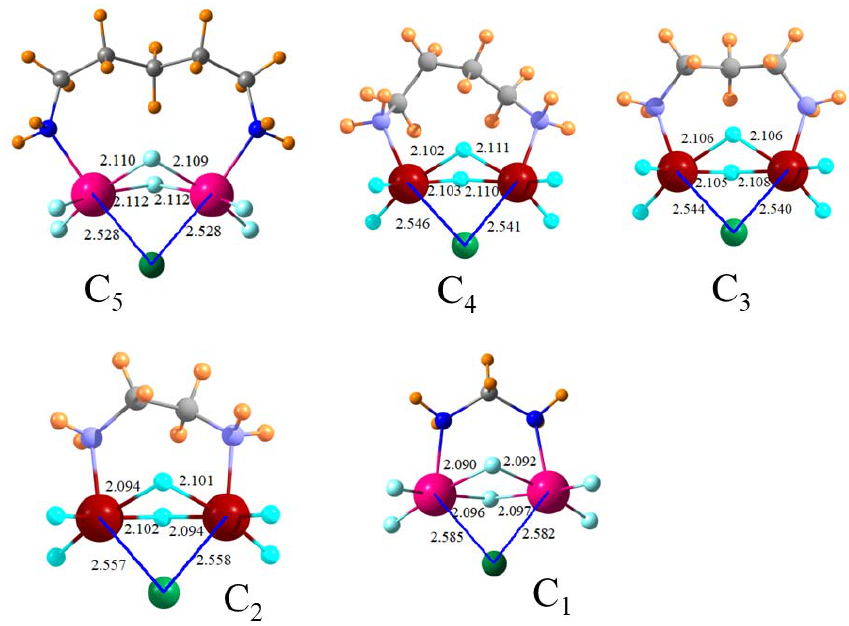
Figure 4. Geometries of cyclic F 3 SnNH 2 (CH 2 ) n NH 2 SnF 3 dications (C n ) with Cl − . Distances in Å, angles in degrees.